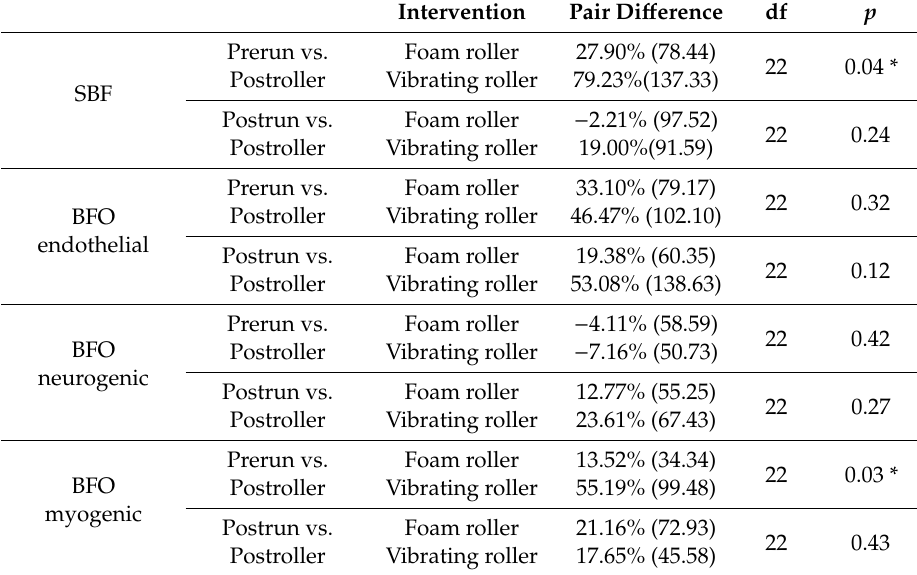
Table 5. The analysis of relative changes in normalized SBF and BFO